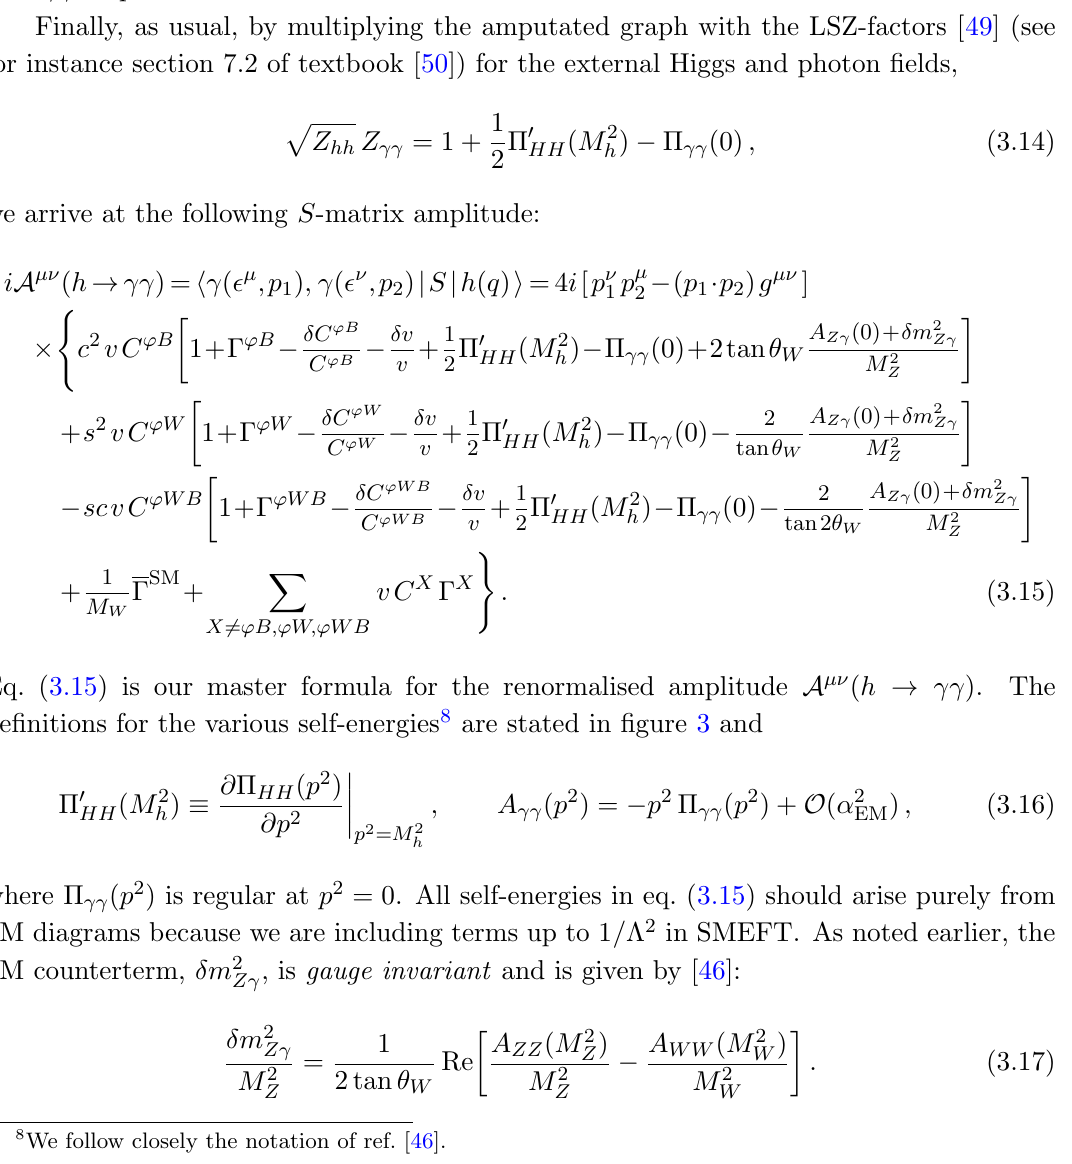
Figure 3 . De(cid:12)nitions for Higgs and vector boson ( V = (cid:13); Z; W ), 1PI self-energies. (cid:14)m 2 (given below) is gauge invariant independently of the renormalisation condition for Z(cid:13) the Higgs tadpole. This is practically very useful for proving the gauge invariance of the h (cid:13)(cid:13) !